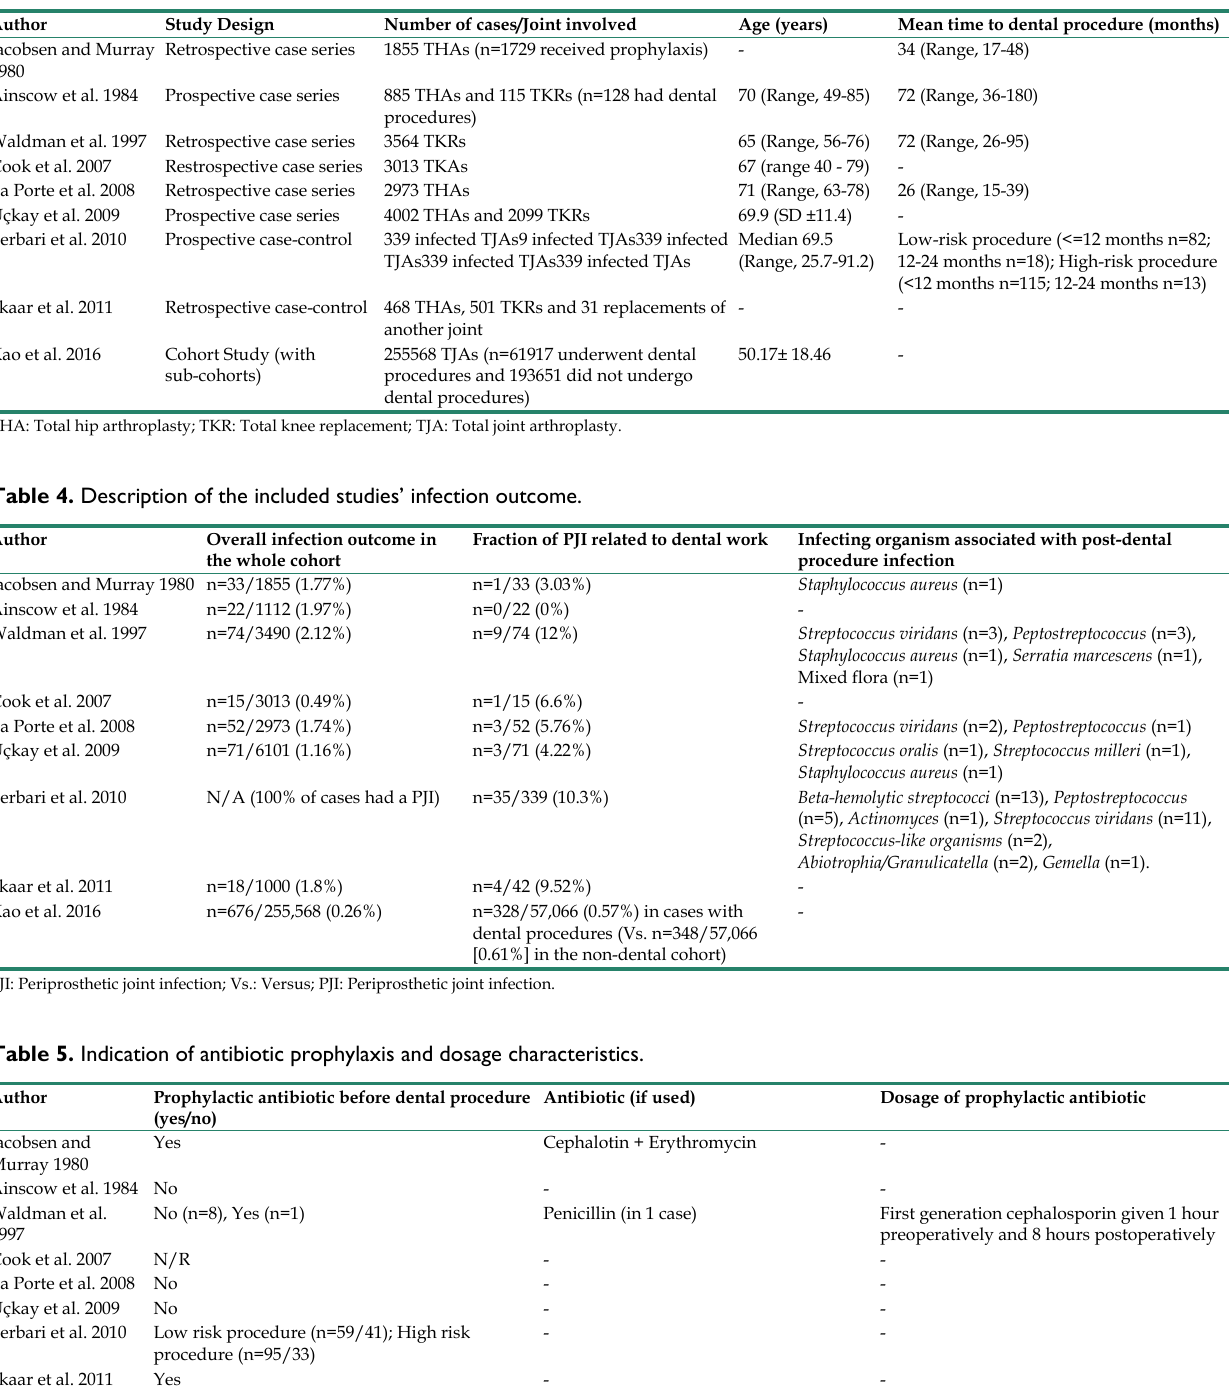
Table 3. Demographic characteristics of the included studies.